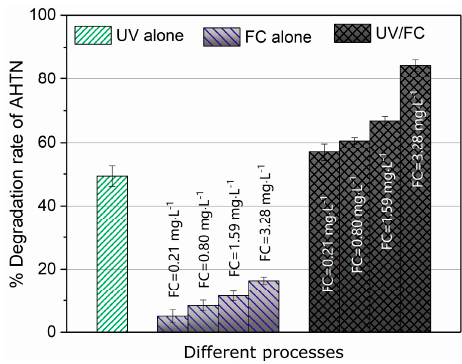
Figure 1. Degradation efficiency of tonalide (AHTN) by UV photolysis, chlorine, and UV/FC ([AHTN] 0 = 1.0 mg · L − 1 , pH = 7.0, 25 ± 1 ◦ C, and UV dose 60 mJ · cm − 2 ).